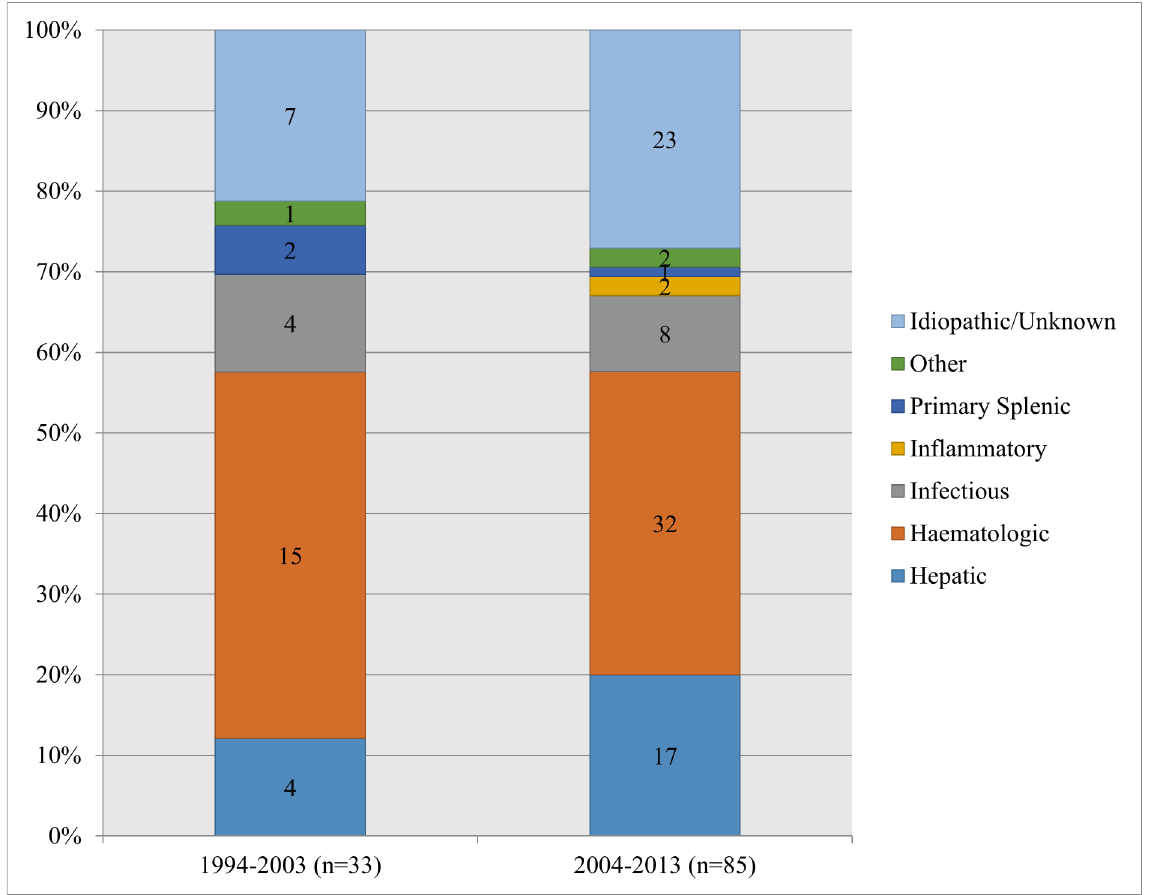
Fig 1. Distribution of diagnostic groups. Distribution of diagnosticgroups for patients diagnosedwith splenomegaly over the time periods1994–2003and 2004–2013.